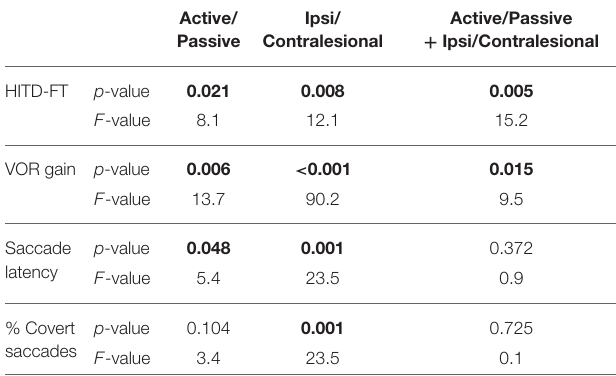
TABLE 2 | Repeated measures GLM-ANOVA analyses of HITD-FT scores, gain, saccade latency and frequency of covert saccades, determining if the performance depended on active/passive head impulses and on ipsilesional/contralesional head movement directions.